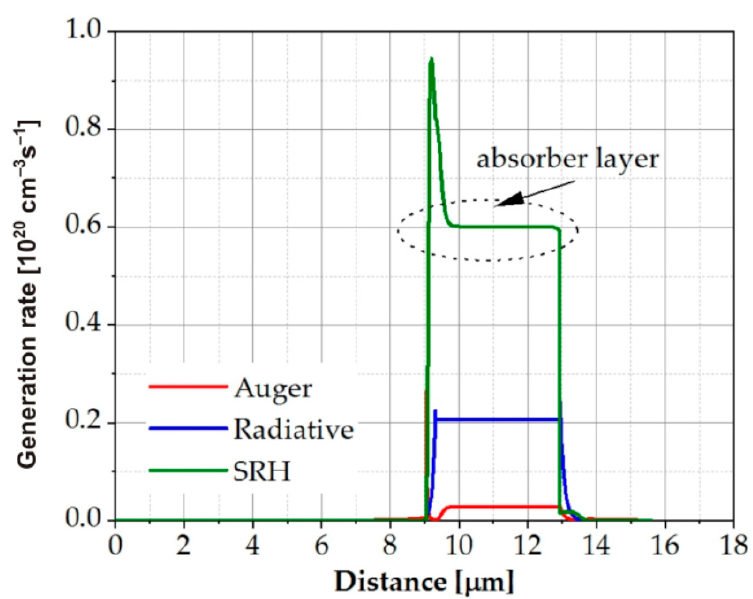
Figure 6. Auger, radiative, and SRH generation rates in the reverse biased SWIR detectors at temperature T = 300 K.